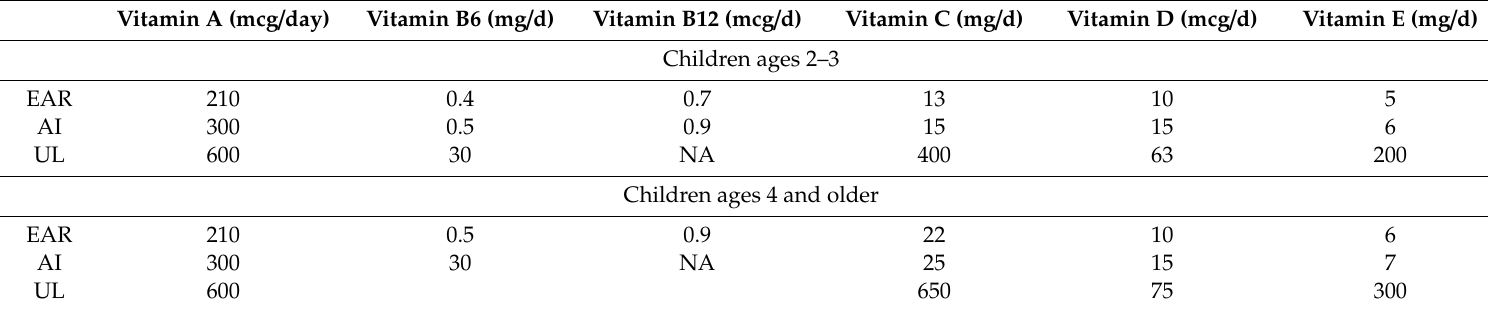
Table 1. Vitamin specific dosage recommended by the Institute of Medicine and Health Canada for Estimated Average Requirements (EAR), Recommended Dietary Allowances and Adequate Intakes (AI), and Tolerable Upper Intakes Levels (UL).